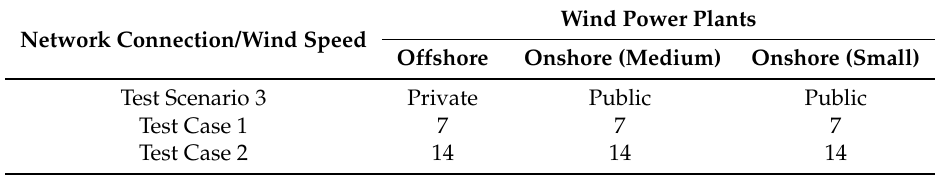
Table 9. Test Scenario 3—with Public Network Connections for both Onshore WPPs.